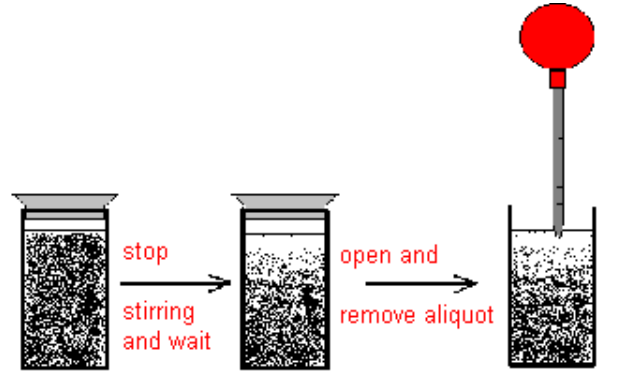
Figure 19. Removal of aliquot from reaction suspension for dilution and